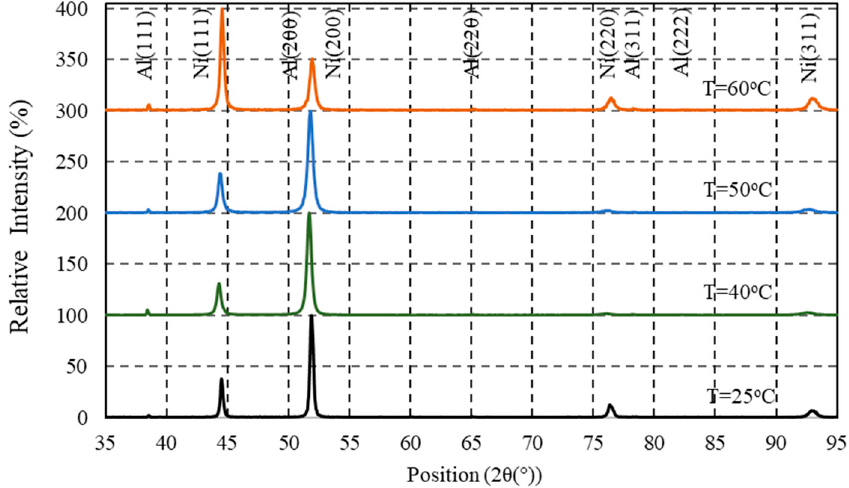
Figure 3. The XRD patterns of Ni-Mo/Al composite coatings obtained at different temperatures.